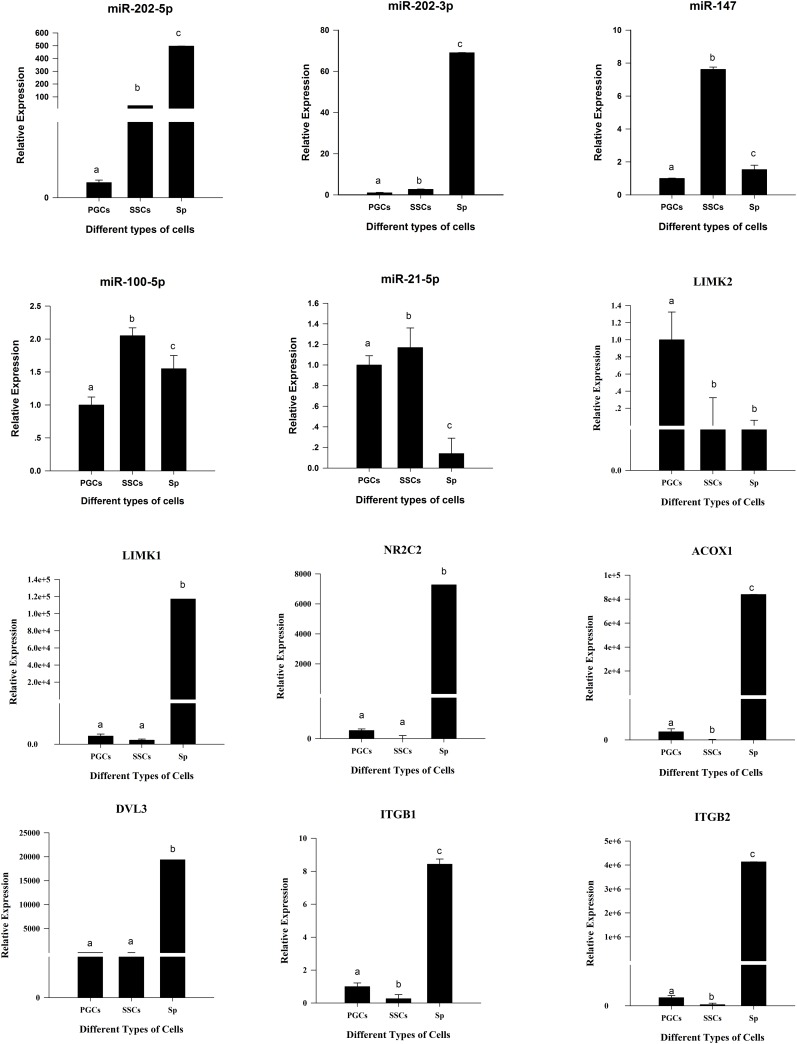
Relative Expression of candidate miRNAs and genes in three types of cells.Lowercase letters indicated p <= 0.01.